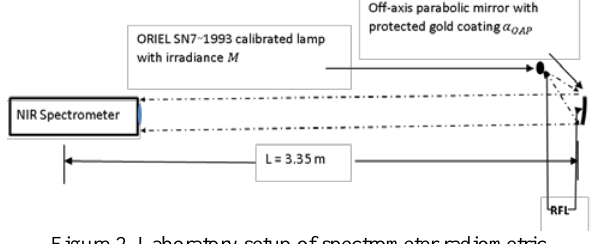
Figure 2. Laboratory setup of spectrometer radiometric calibration.